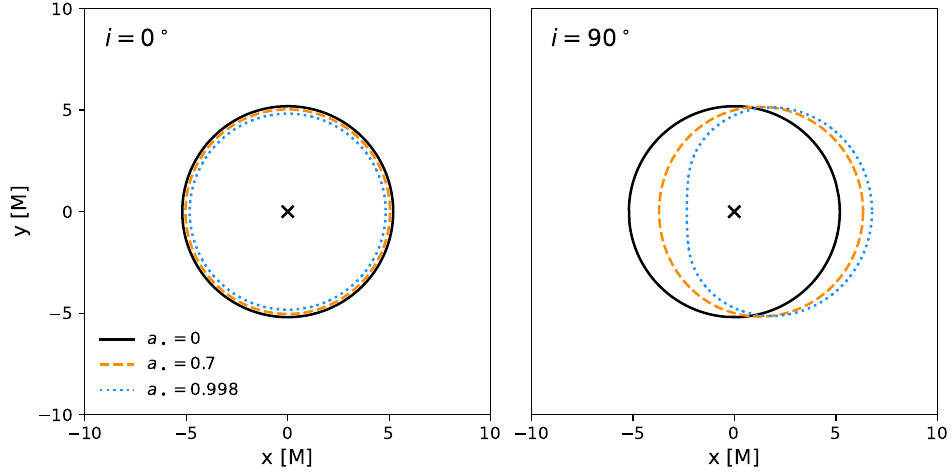
Figure 1. Shape of the n = ∞ photon ring or “critical curve” as a function of spin and inclination, using the analytic formulae provided in Chael et al. [53]. For face-on viewing angles ( left ), the critical curve remains circular and shrinks only by about 7% between 0 and maximal spin. For edge-on viewing angles ( right ), the critical curve becomes horizontally displaced and asymmetric as spin